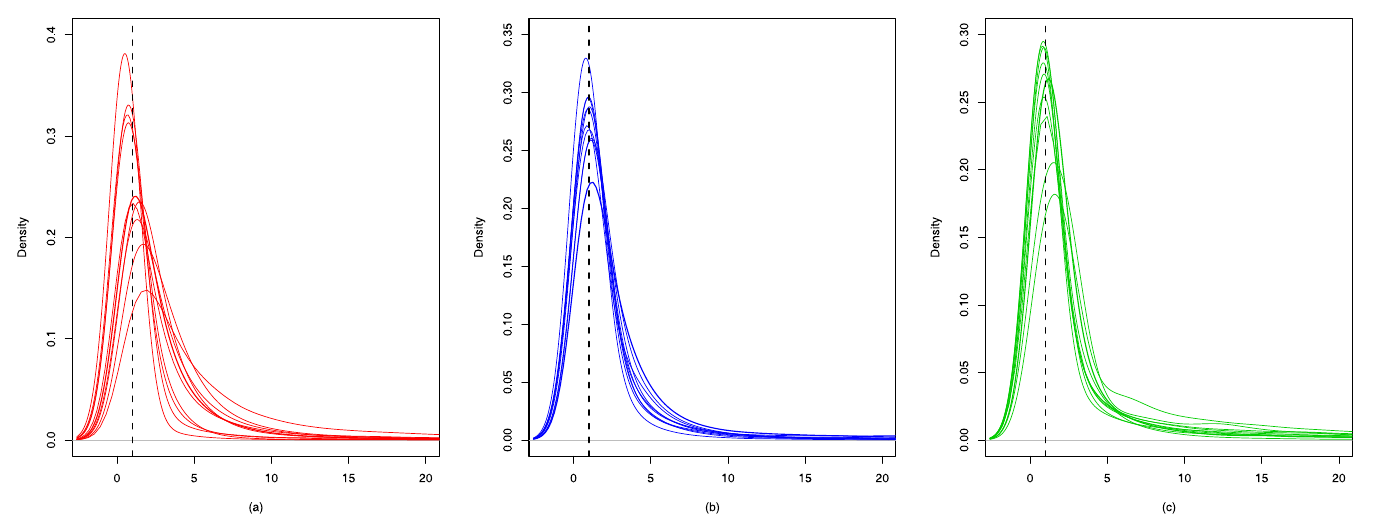
Fig 3. Density curves of the quotients between estimated and true latent distances. (a) θ = 1.7; (b) θ = 2.0; (c) θ = 2.3.